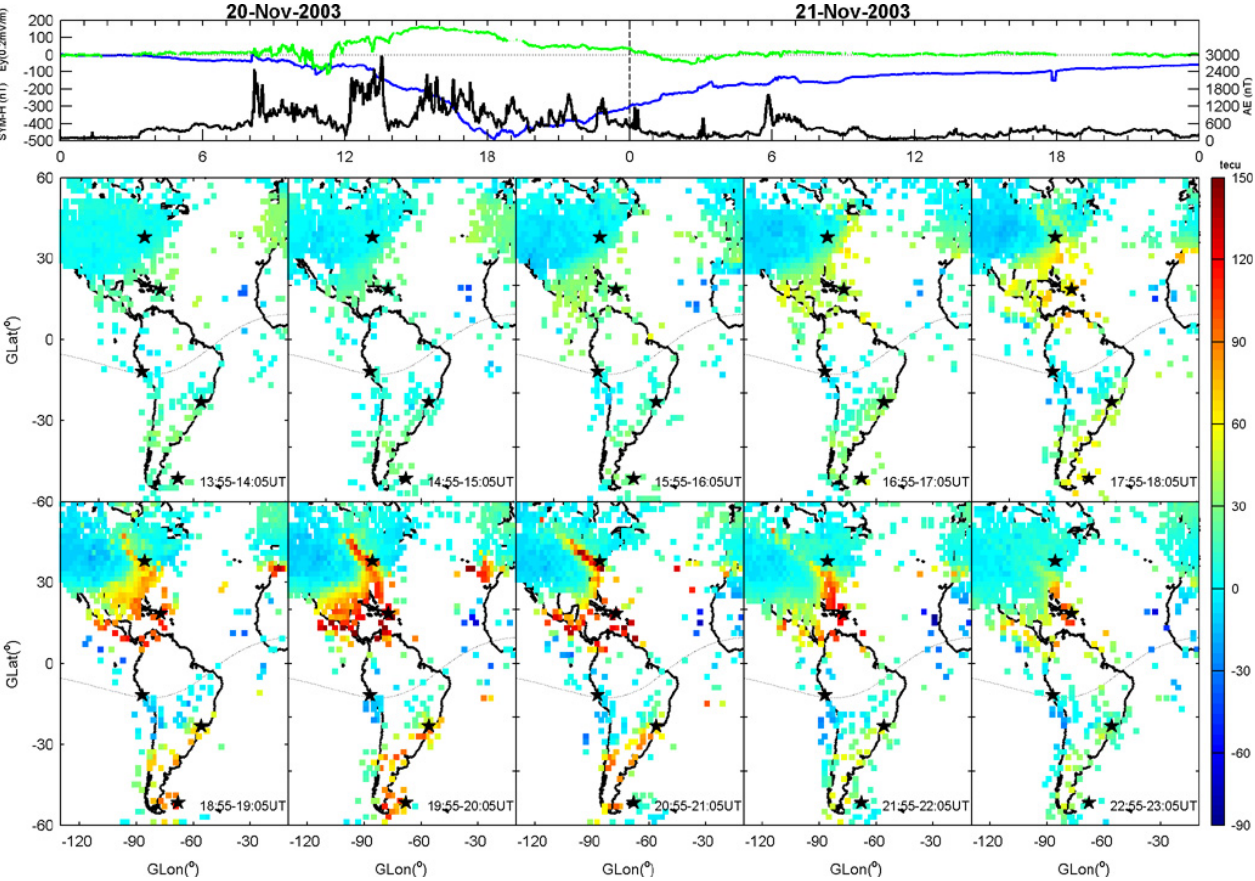
Fig. 1. The top panel shows the SYM-H (blue), AE (black) and IEF E y (green) from OMNI database. The bottom panels illustrate the differential ground-based GPS TEC from 14:00–23:00UT between the storm day on 20 November and the undisturbed state on 19 November. The unit of differential TEC is TECu (1TECu=10 16 electronsm 2 ). The geomagnetic equator is indicated by the dotted lines and the stars denote the ionosonde stations used in the